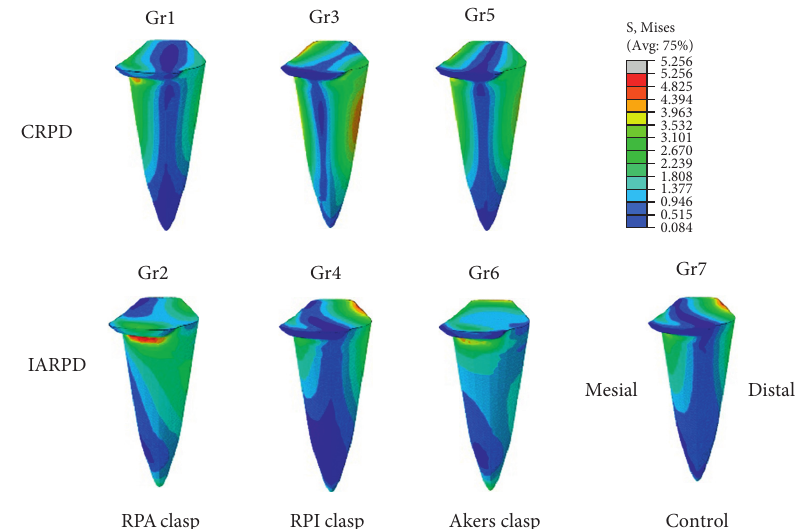
Figure 7: The stress distribution pattern on the abutment root surfaces following the application of a total 200N vertical loading at distal extension ridges of the CRPD and IARPD with various retentive clasp